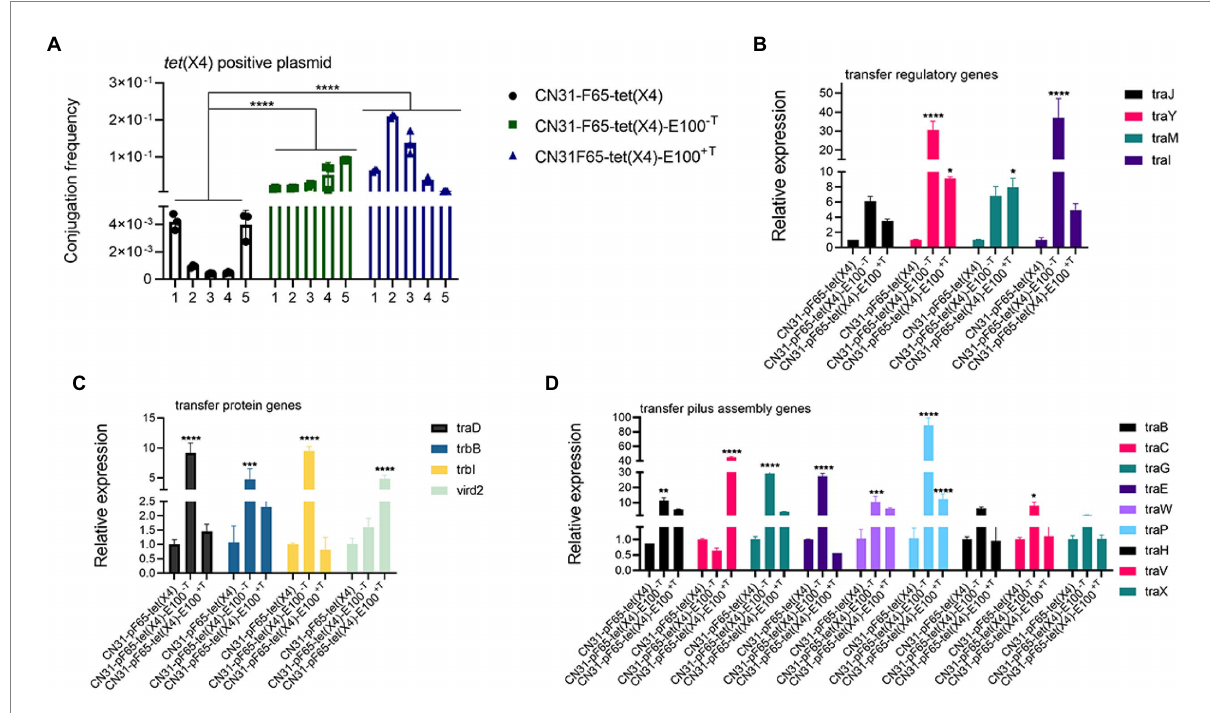
FIGURE 4 Improved conjugation frequencies observed in the evolved strains. (A) Comparison of tet (X4)-positive plasmid conjugation frequency between ancestral and evolved strains. (B) Comparison of the expression levels of conjugative transfer regulatory-related genes between ancestral and evolved strains. (C) Comparison of the expression levels of conjugative transfer genes between ancestral and evolved strains. (D) Comparison of the expression levels of conjugative transfer pilus assembly genes between ancestral and evolved strains.